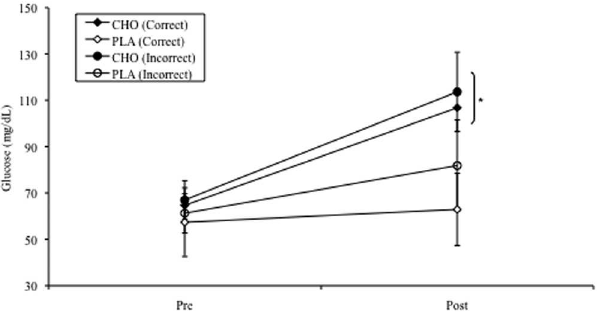
Figure 1 - Glucose measurements (mg/dL) from trained indivi- duals who completed two 60-min cycle ergometry trials at , 80% VO 2peak . Data are presented as group means and standard deviations (bars). One trial was carbohydrate